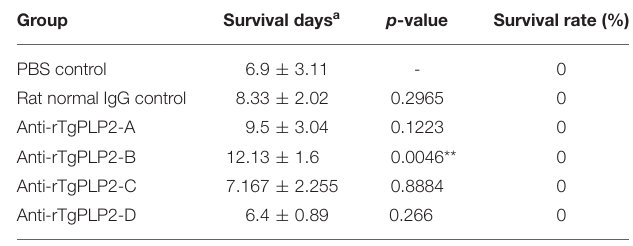
TABLE 2 | Survival days of BALB/c mice in passive immunization